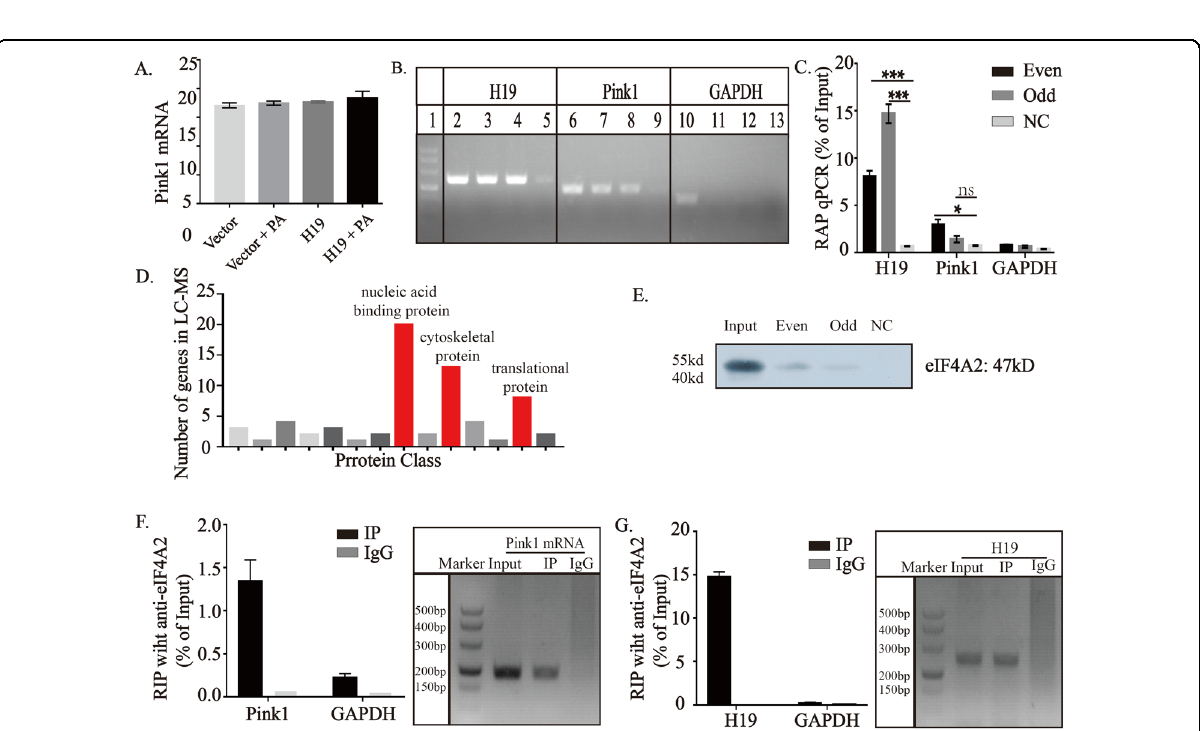
Fig. 5 H19 interacts with eIF4A2 protein and inhibits Pink1 mRNA translation. A Effects of PA and H19 on cellular Pink1 mRNA levels detected by RT-qPCR. No statistically signi fi cant differences were found among the four groups. B Results of RAP using H19 probes. H19 probes were divided into two groups: odd and even, and Lac Z was used as an external reference. Lane 1 represents the marker (500, 400, 300, 200, 150, 100); lanes 2, 6, and 10: inputs for H19, Pink1, and GAPDH, respectively; lanes 3, 7, and 11: even groups of H19, Pink1, and GAPDH, respectively; lanes 4, 8, and 12: odd groups of H19, Pink1, and GAPDH, respectively; lanes 5, 9, and 13: negative control groups of H19, Pink1, and GAPDH, respectively. RT-qPCR was carried out to verify that H19 and Pink1 mRNA could be detected in the molecular complex precipitated using H19 probes. C RT-qPCR detecting RNA of H19 and Pink1 in the products yielded by RAP using different H19 probes. D Result of LC-MS/MS using proteins yielded by RAP using H19 probe. Bar charts showed the classi fi cation of proteins and numbers of included genes. E Western blot detecting the presence of eIF4A2 in the proetins yielded by RAP using H19 probe. F, G RT-qPCR detecting the presence of Pink1 and H19 in the RNA yielded by RIP using eIF4A2 antibody. Statistical analyses were performed base on three biological replicates. Data in B are expressed as mean ± SEM. * P < 0.05; ** P < 0.01; *** P < 0.001.